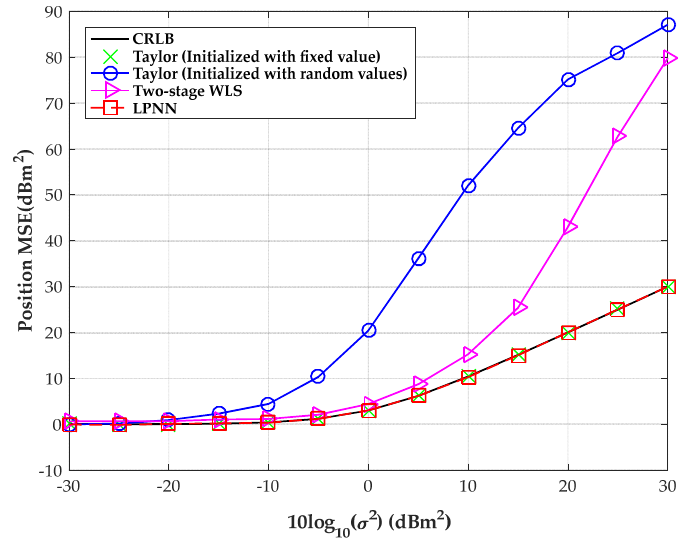
Figure 11. MSE versus level of measurement noise with the source position located at ( 300, − 280 )